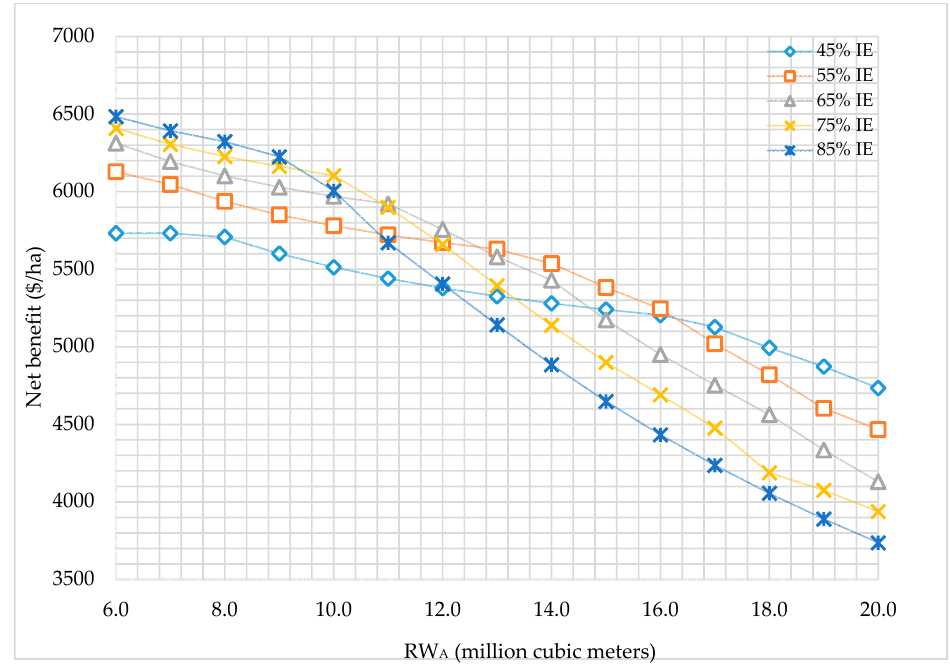
Figure 6. Net benefit per hectare ($/ha) predicted using reclaimed water type A (RW A ) with five different irrigation efficiencies (IEs).